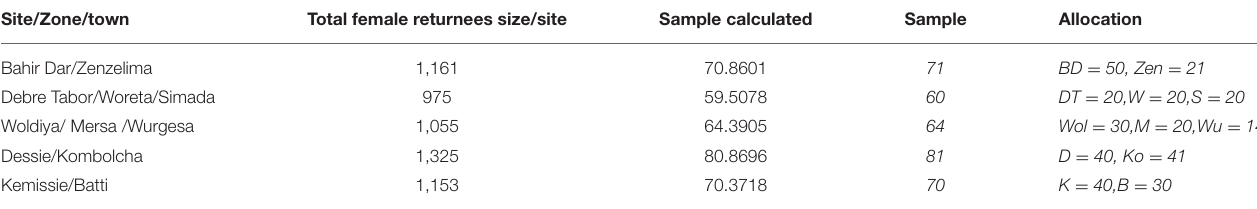
TABLE 1 | Proportional allocation of sample.